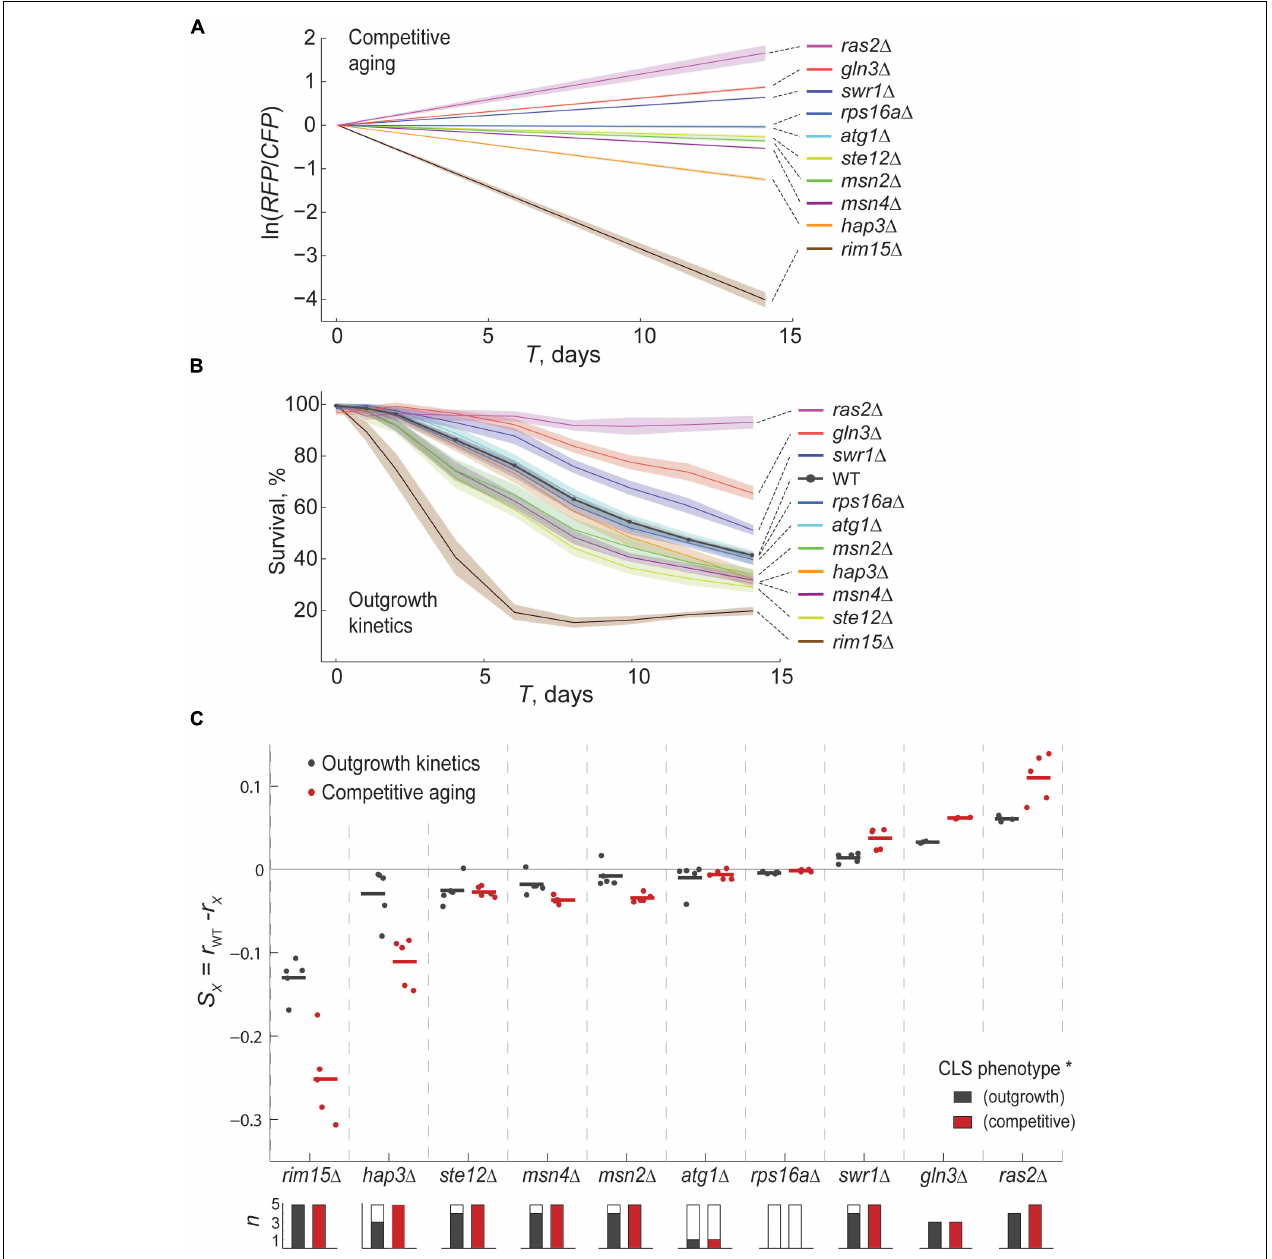
FIGURE 2 | The competitive-aging method is accurate and replicable. (A) Relative survivorship estimated by competitive aging. The modeled ln(RFP/CFP) is shown for the WT and ten mutant strains at each T i point, averaged for at least six technical replicates along with the CI 95% (shaded area). (B) Percent of surviving cells in monoculture over time measured by the shift in outgrowth kinetics; the mean and CI 95% are shown. (C) Average relative survivorship of three to five experimental replicates is shown, expressed either as the difference of individual death rates for monoculture outgrowth kinetics ( r wt − r x , black) or as survivorship coefficients for competitive aging ( S , red). Each data point is the average of at least six technical replicates of monocultures or competitions in an independent experimental replicate. Horizontal lines are the mean of each data series. Stacked bars below the plot indicate the number of replicate plates per sample; solid fraction indicates the number of significant samples compared with the WT distribution ( p < 0.01, t -test; each experimental batch has 31 reference and at least six deletion